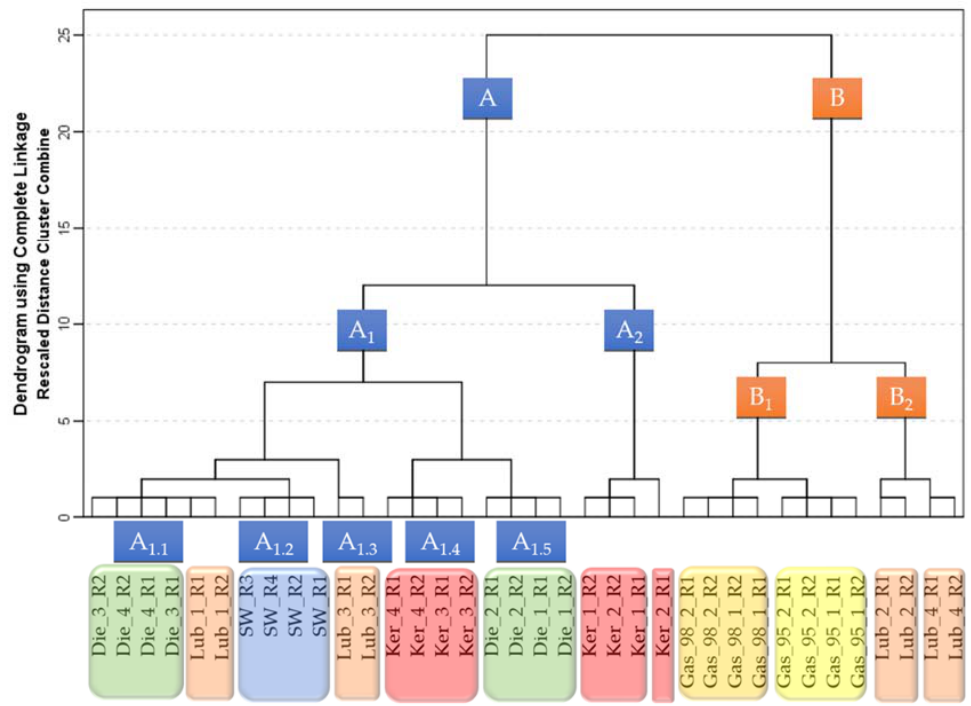
Figure 4. Dendrogram obtained by the hierarchical cluster analysis (HCA) of the pure water and the PDP-added samples (D 36X980 ).